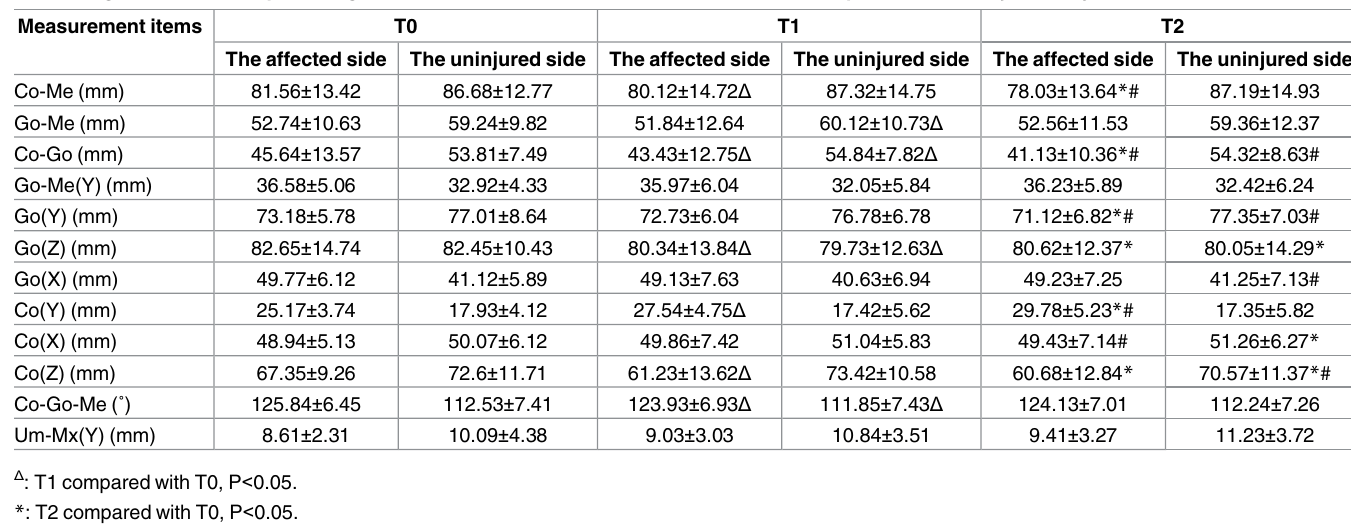
Table 2. The asymmetrical items and their asymmetric indices related to the craniofacial hard tissue structure at the three time points before and after autogenous coronoid process graft reconstruction for the treatment of unilateral temporomandibular joint ankylosis. Measurement